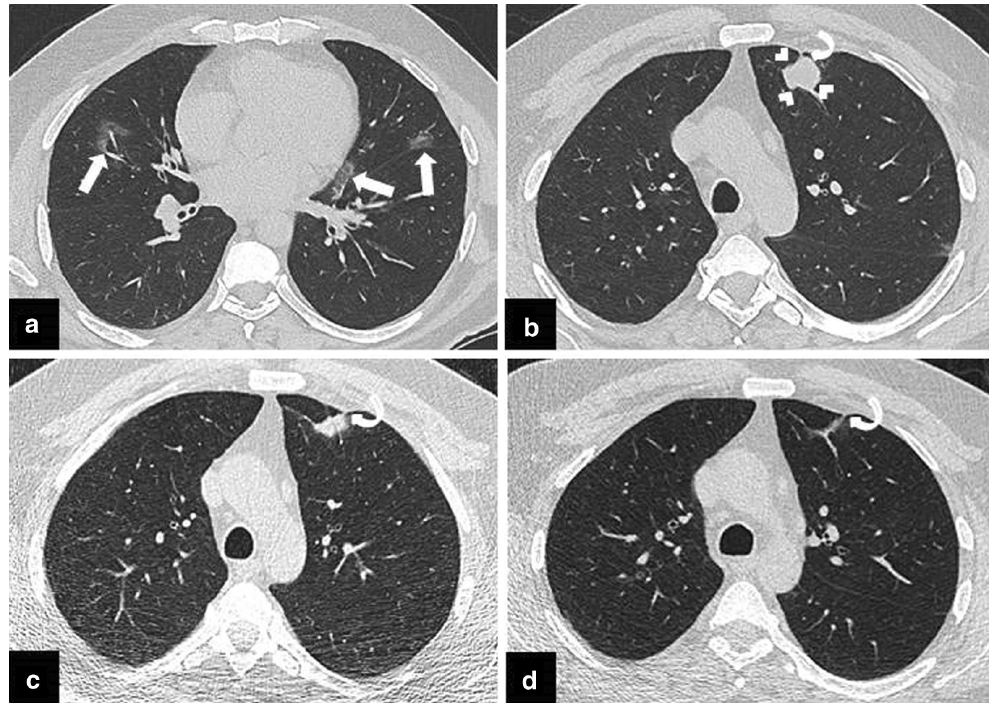
Figure 4. From the publication by Arslan et al. [33] “( a , b ) The initial chest CT scan obtained following PCR test positivity for COVID-19 infection, revealed a few patchy areas of ground glass opacity (GGO) in both lungs (arrows) compatible with COVID-19 pneumonia. An irregularly shaped solid nodule 2 cm in diameter in left upper lobe of the lung was also noted (arrowheads). Percutaneous transthoracic core needle biopsy was scheduled due to suspicion of primary lung cancer. ( c ) CT scan obtained prior to biopsy procedure demonstrated significant size reduction of the